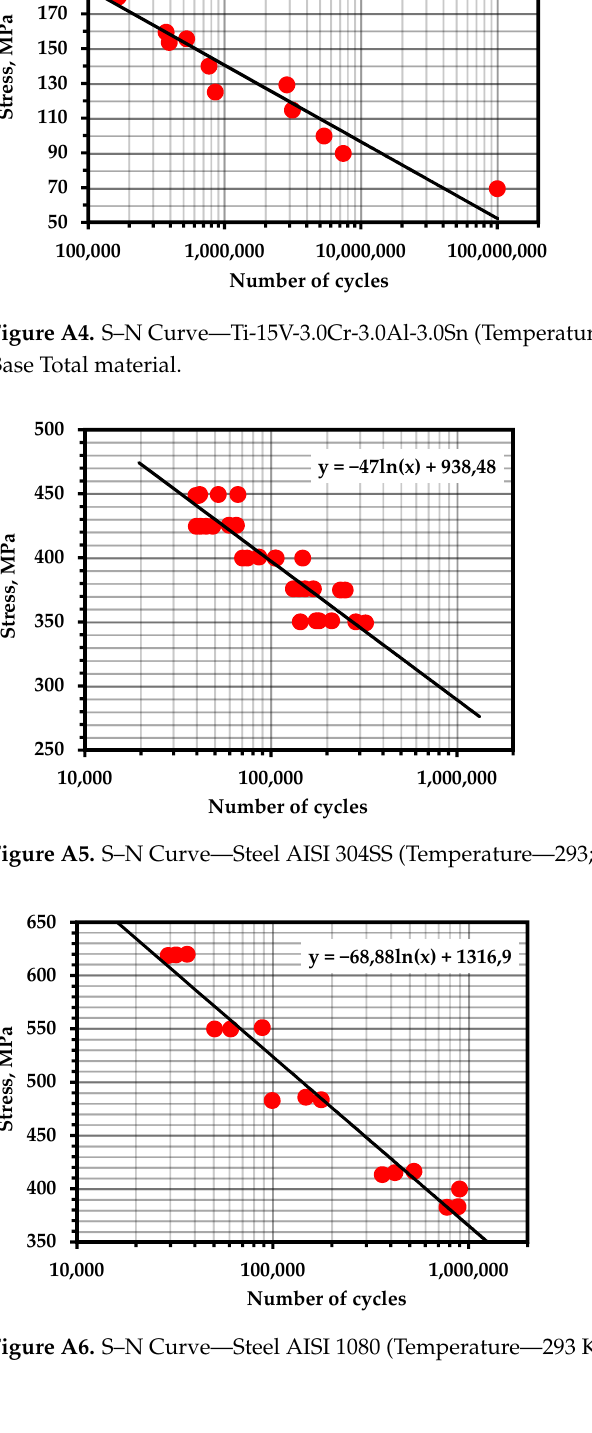
Figure A7. S–N Curve—Steel AISI 1060 (Temperature—293 К ; frequency—30 Hz; R = − 1) [102]. Figure A8. S–N Curve—A516 Grade 70 Steel (Accepted as an analogue of SA333) (Temperature— 293 К ; frequency—30 Hz). Source—Base Total Material.